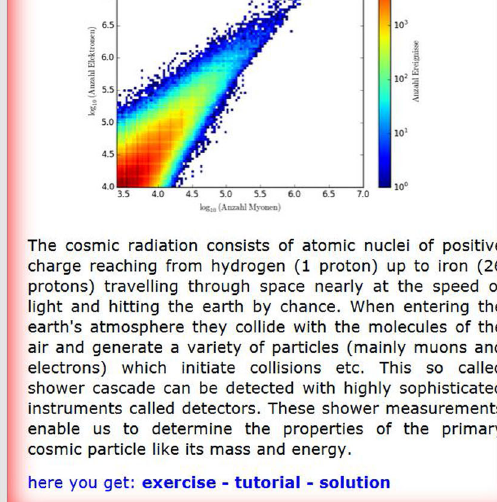
Fig. 15 Impression of the tutorial section of KCDC